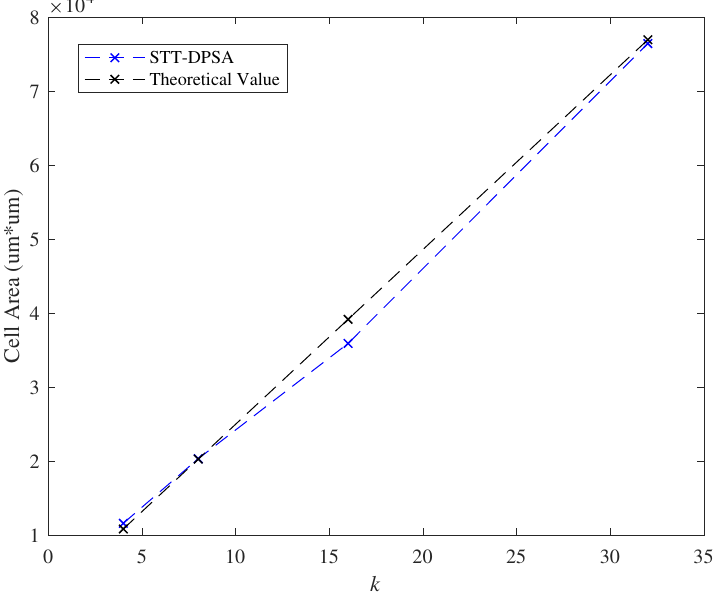
Figure 18. Effect of the parameter k with respect to the cell